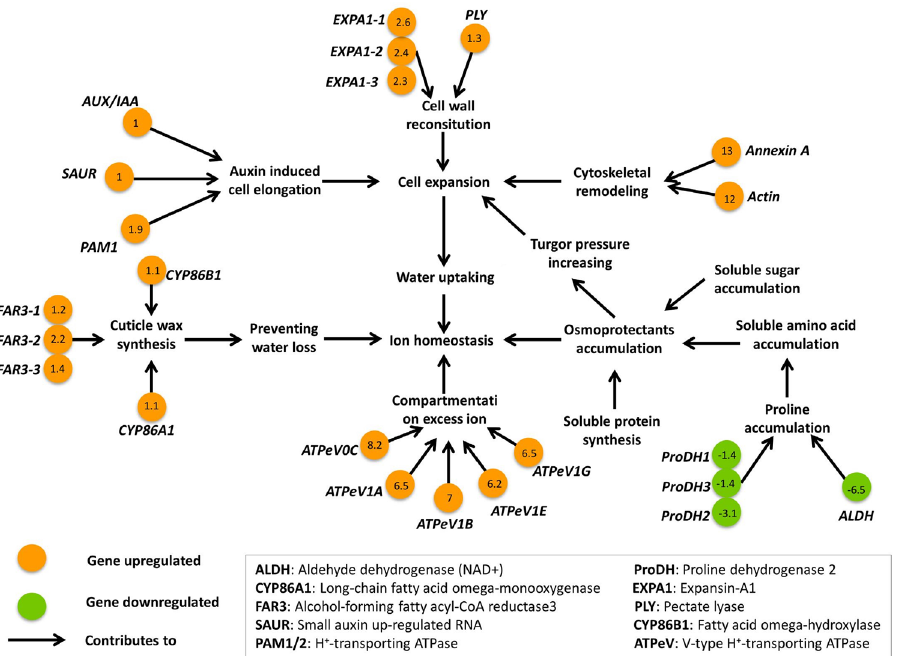
Figure 6. Global view of the identified differentially expressed genes (DEGs) involved in ion homeostasis regulation. Orange and green colors represent up and down-regulated DEGs, respectively. The numbers in the circles represent the fold